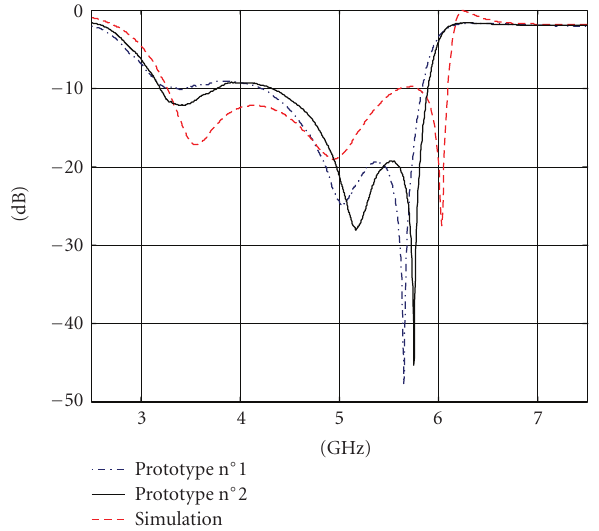
Figure 14: Measured and simulated reflection coe ffi cient magni- tude | S 11 | versus